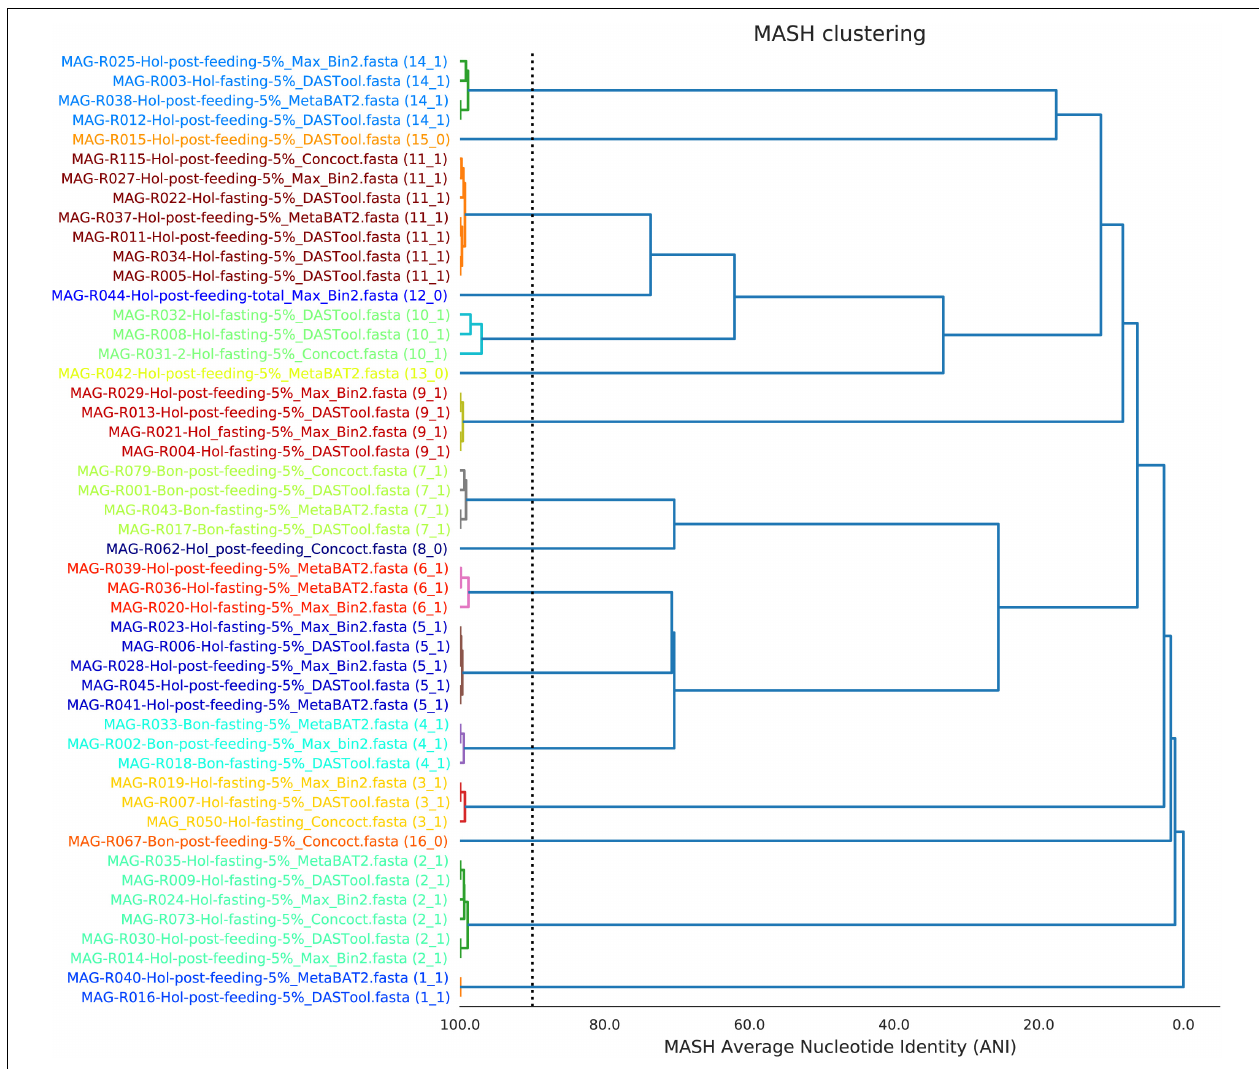
FIGURE 1 | Clustering of the high-quality metagenome-assembled genomes (MAGs) found in the 5% fraction of the total sample of ruminal fluid of the Bon and Holstein animals according to MASH-ANI distances.